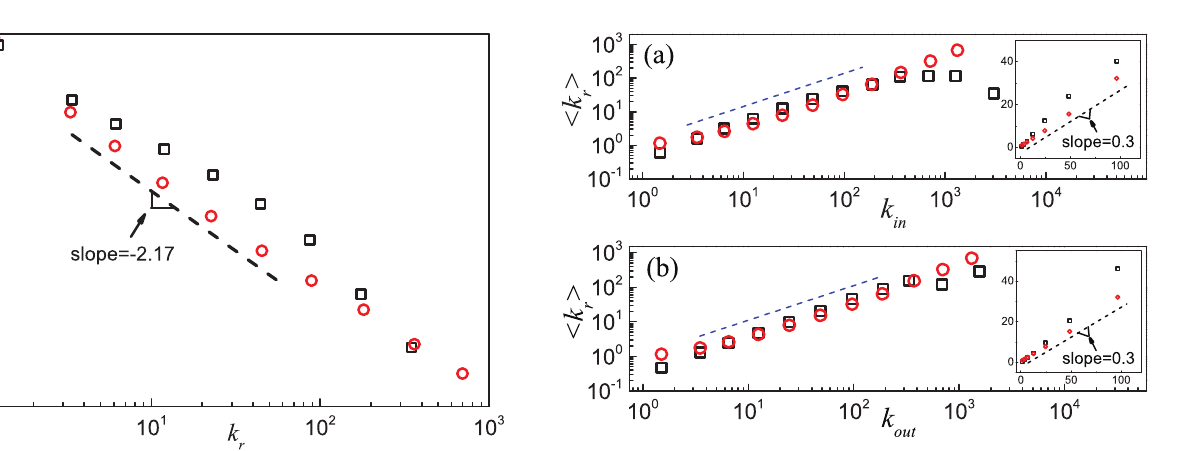
Figure 4. Reciprocal degree distributions of the Epinions social network and the model. Results of the Epinions social network (black squares) and simulation results (red circles) based on the model are shown. Analytic treatment (see Eqs. (17) and (31)) suggests a scaling behavior with an exponent { 2 : 17 , as shown by the dash line. Data points are averages over the logarithmic bins of the reciprocal degree k r .